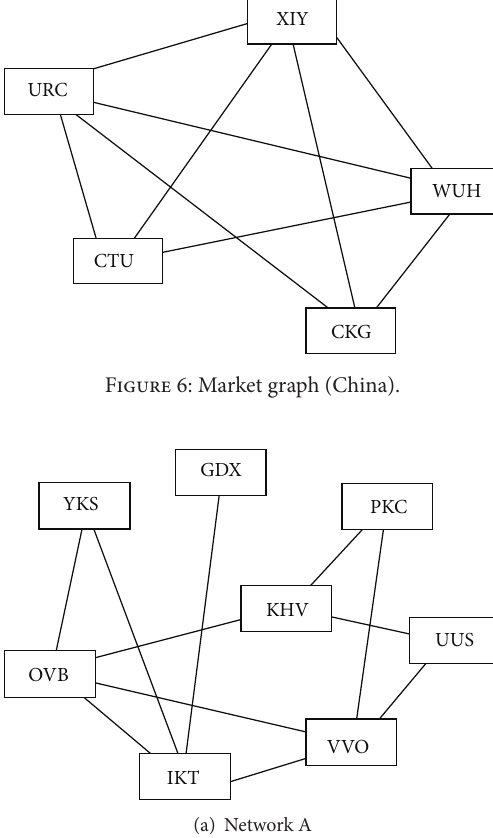
Figure 8: Operating networks